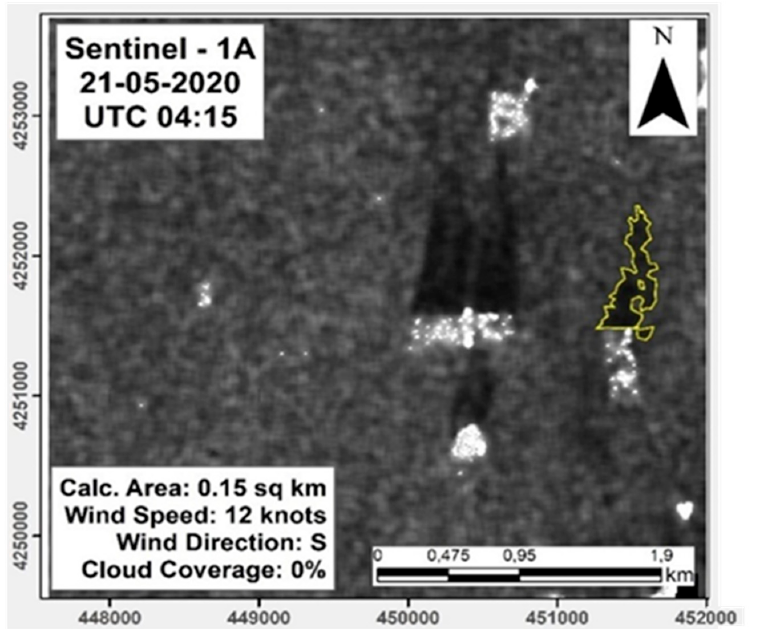
Figure 12. An example of partial detection; the algorithm correctly detected some of the biogenic 294 oil films that existed in the scene, but not all of them. 295 In situ photos from the Site 1 aquaculture farm were acquired to further examine the 296 validity of our results ( Error! Reference source not found. ). Error! Reference source not 297 found. shows an example of a photo captured on 26/07/2020 (left) and the corresponding 298 Sentinel ‐ 2 image (right). The dark formation detected from the satellite image is most 299 likely in a low wind area. The dark spot detected was classified as a similar feature based 300 on its size, and was excluded.